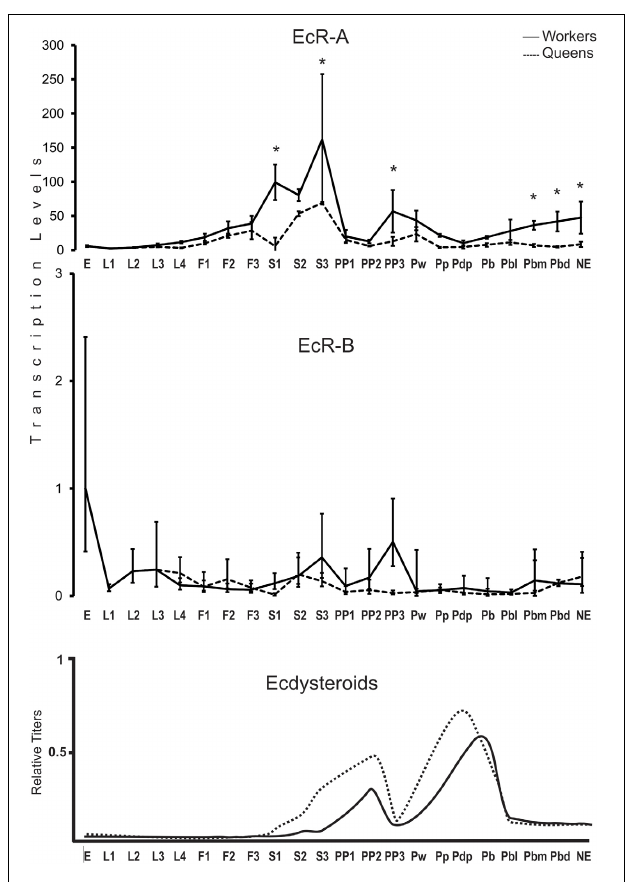
FIGURE 2 | Developmental expression profile of the EcR gene in A. mellifera queens and workers. EcR-A and EcR-B transcript levels were measured by RT-qPCR. Bars represent means ± S.E.M. of three biological replicates, each run as three technical replicates. Asterisks indicate a statistical difference (Mann–Whitney Test, P ≤ 0 . 05) between queens and workers for the respective developmental phase. See Table 1 for a description of the developmental phases. Hormone titers are based on Rachinsky et al. (1990) and Pinto et al.